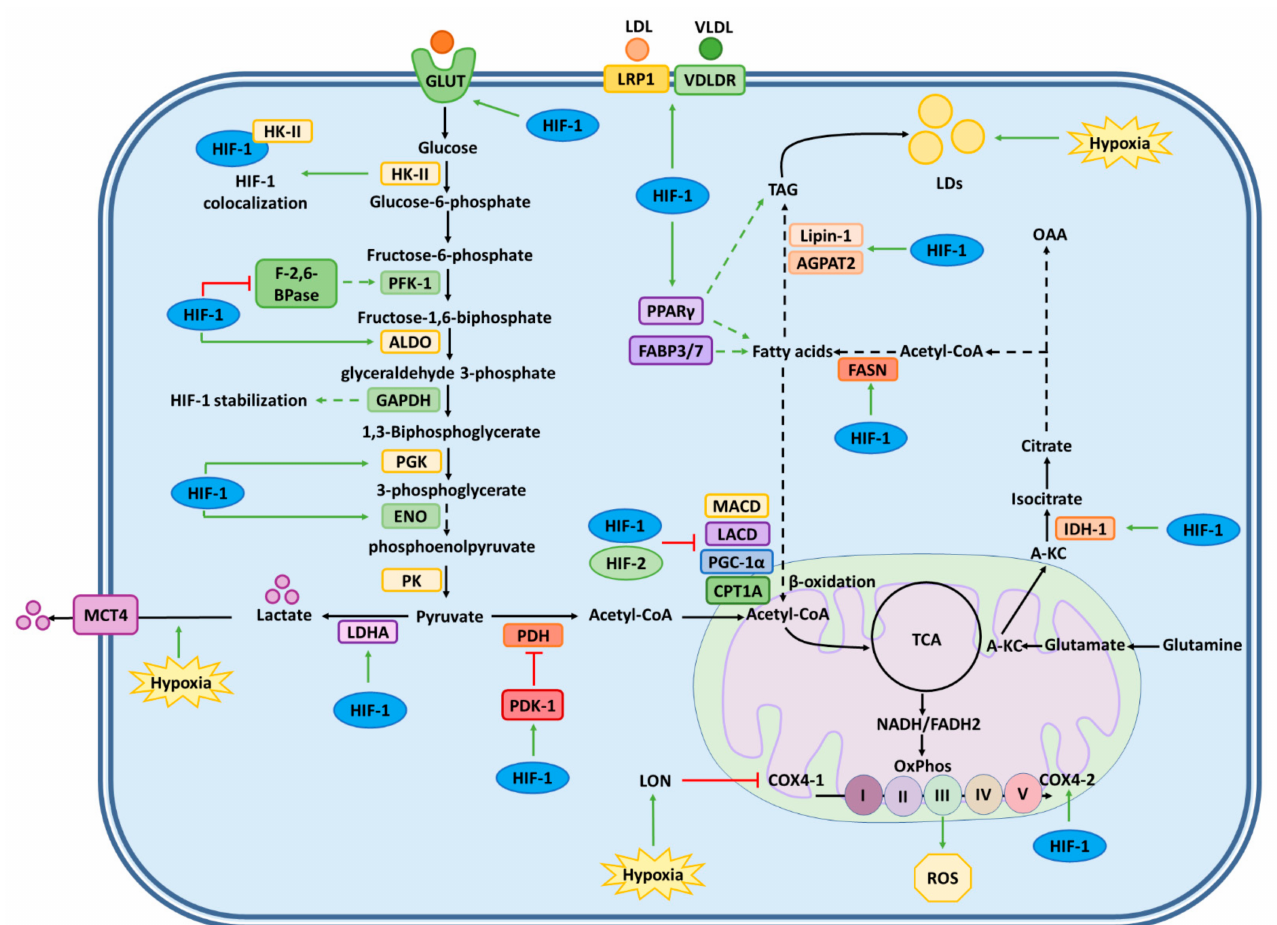
Figure 2. Metabolism regulation under hypoxia conditions. Cellular metabolism is affected by hypoxic conditions. Under low oxygen conditions, HIF-1 increases the transcription of enzymes involved in glucose catabolism. Similarly, HIF-1 enhances the anaerobic lactate pathway by increasing the transcription of lactate dehydrogenase A (LDHA). Furthermore, HIF-1 promotes the transcription of glucose transporters to offset low ATP availability. Conversely, pyruvate dehydrogenase kinase 1 (PDK-1) is induced, causing phosphorylation and inactivation of pyruvate dehydrogenase (PDH) to regulate the levels of acetyl-CoA. Additionally, HIF-1 upregulates isocitrate dehydrogenase-1 (IDH-1) and aconitase expression, causing a reduction in acetyl-CoA availability and reducing the activity of the tricarboxylic acid cycle (TCA) to decrease ROS generation by the mitochondria. Furthermore, hypoxia promotes the transcription of LON genes, inhibiting the expression of the Cytochrome c oxidase subunit 4 isoform 1 (COOX4-1). Altogether, HIF-1 upregulates COOX4-2, allowing a